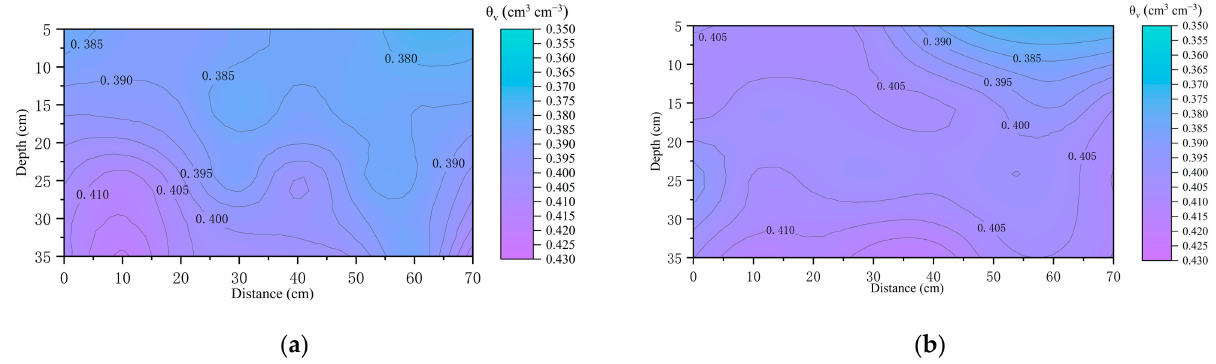
Figure 6. The measured 2D distribution of soil water content at the end of experiment: ( a ) Measured distribution under W1; ( b ) measured distribution under